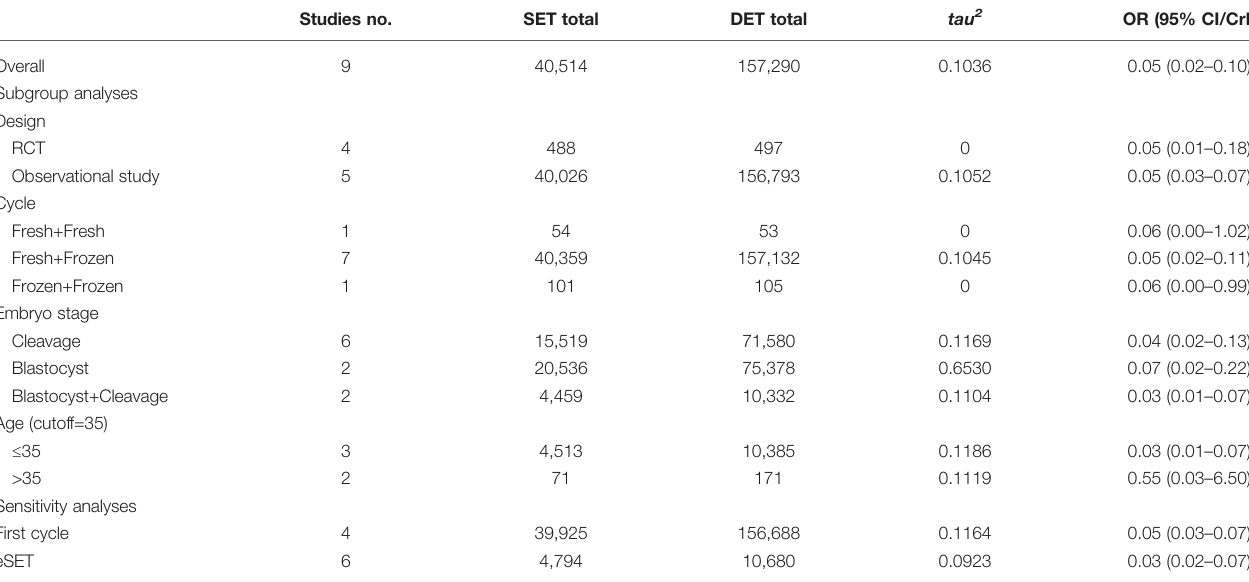
TABLE 2 | Sensitivity and subgroup analyses comparing cumulative mutiple live birth rate after two consecutive cycles of SET (2SETs) and one cycle of DET. Studies no.